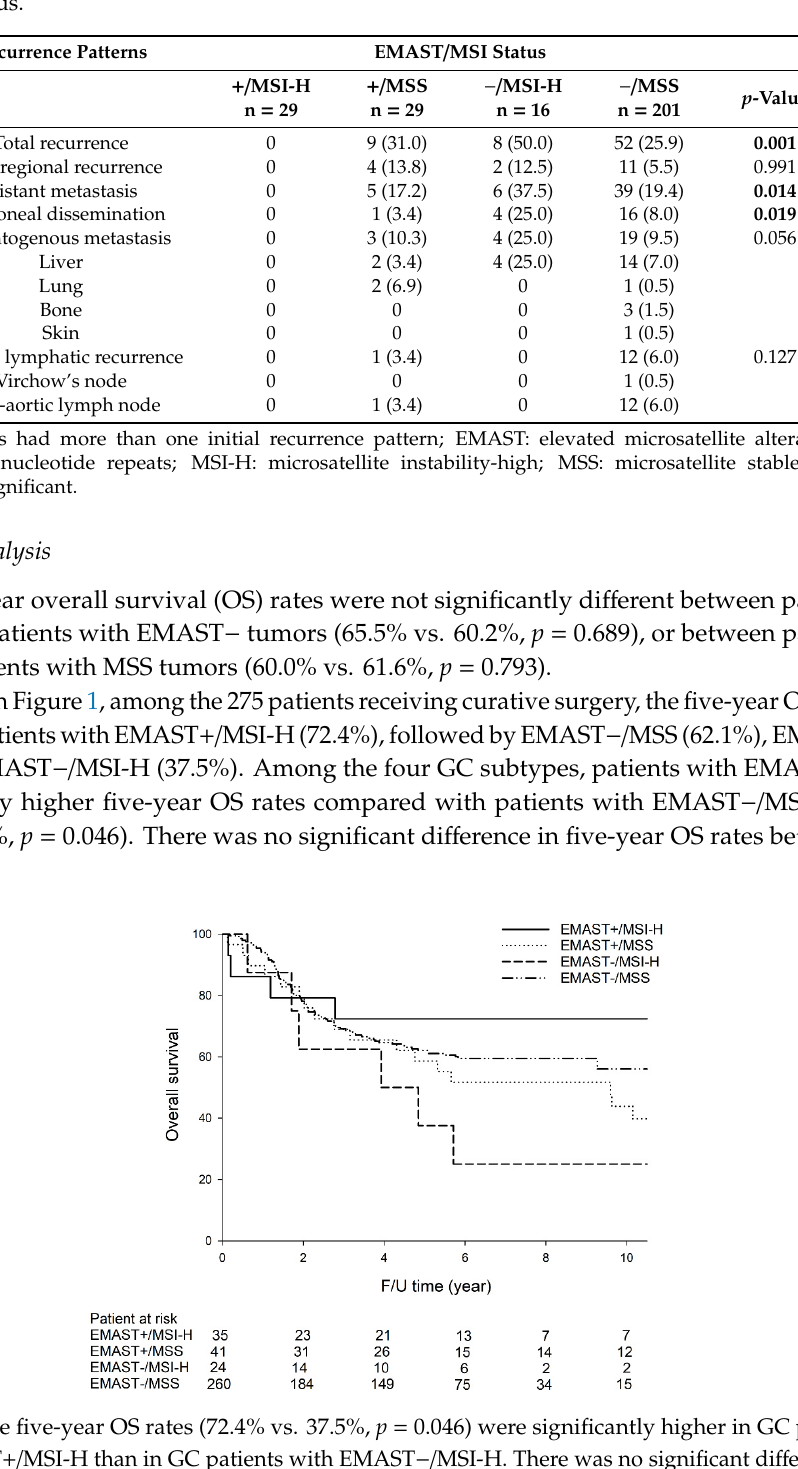
Table 7. Multivariate Cox proportional-hazards model for the analysis of the overall survival and disease-free survival for gastric cancer patients after curative surgery. Risk Factors